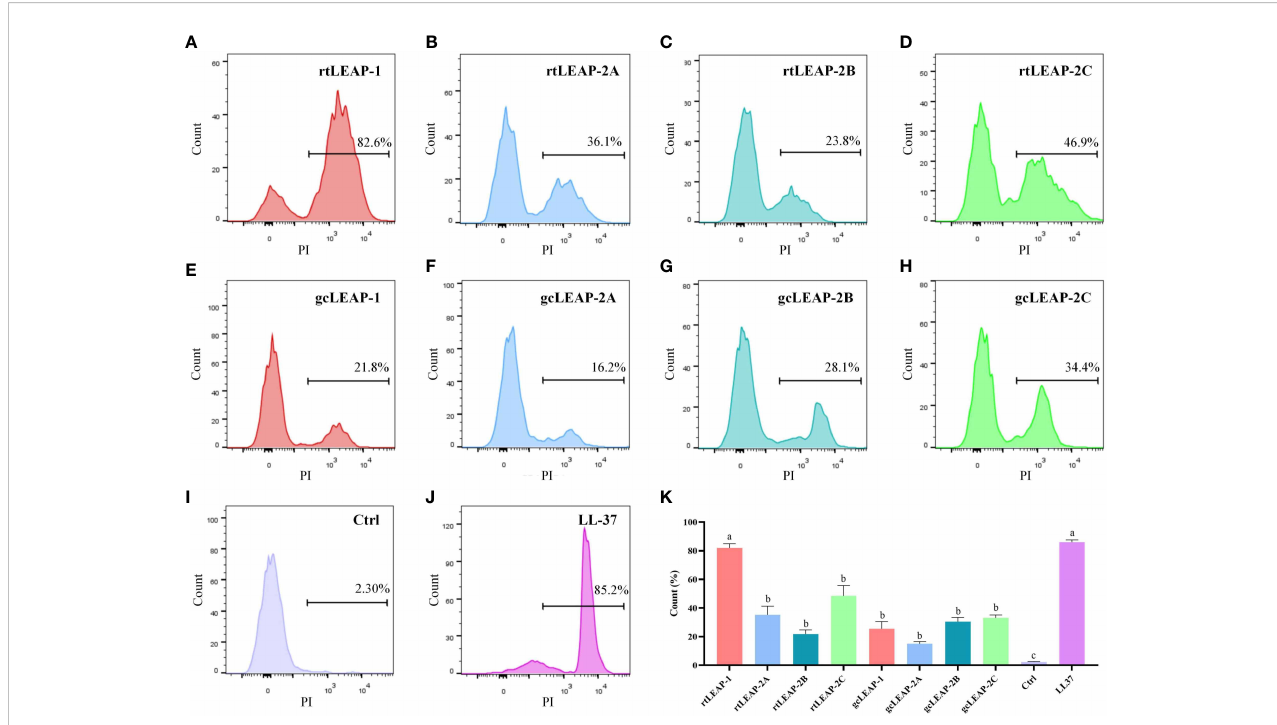
FIGURE 6 Antibacterial mechanisms of LEAPs. (A – J) Membrane permeability of V. fl uvialis treated with LEAPs. The bacteria were incubated with LEAPs (8 m M) at 37°C for 1 h, and a bacterial suspension without peptide was included as a control (Ctrl). Then PI (9 m M) was added and the in fl ux of PI was detected by fl ow